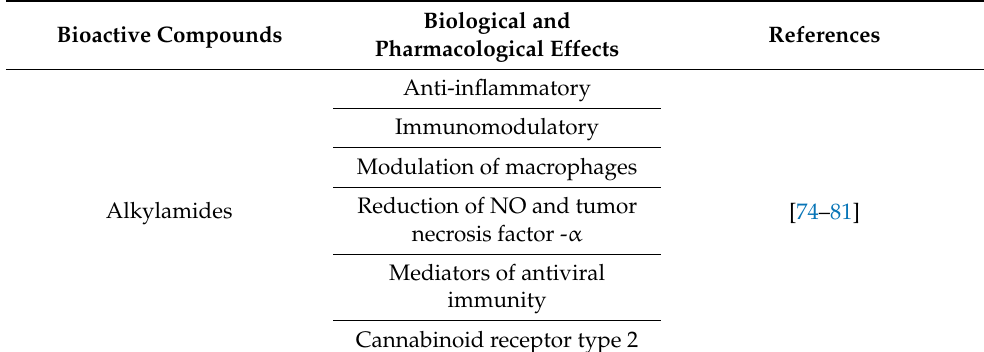
Table 2. Biological and pharmacological effects of the bioactive compounds of Echinacea purpurea (L.)